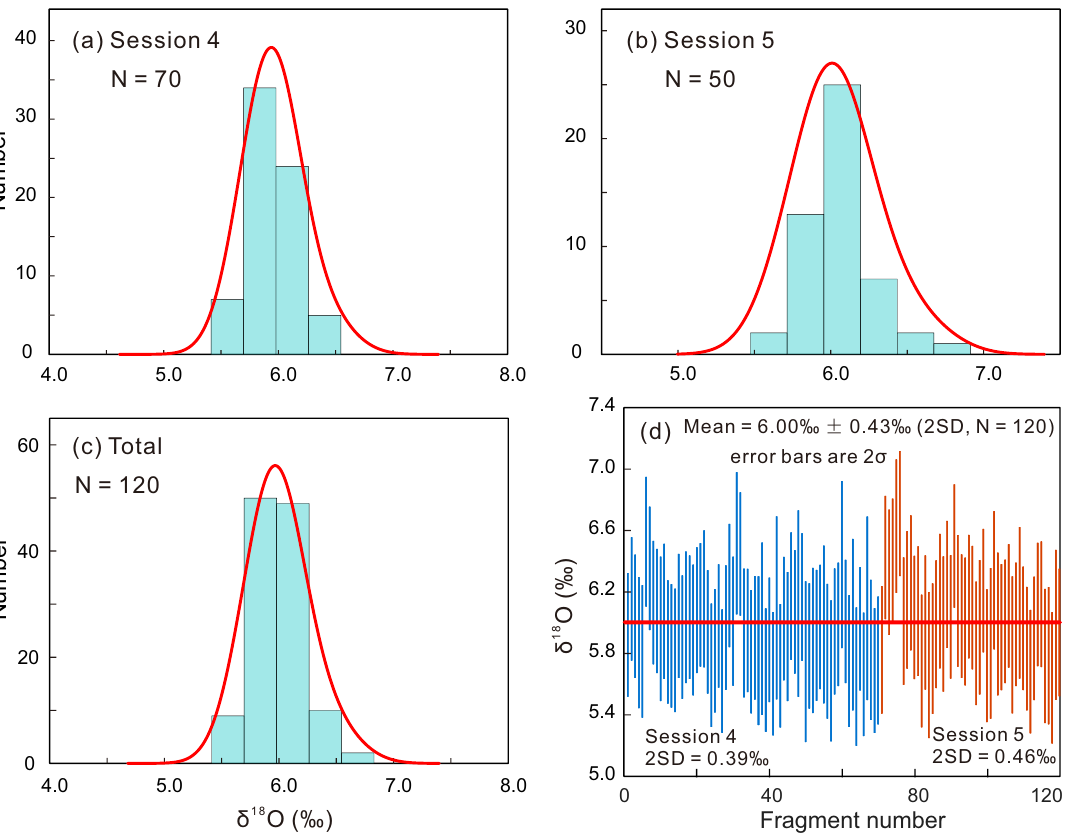
Figure 6. ( a – c ) Frequency distributions of RW-1 SIMS δ 18 O values with instrumental mass fractionation (IMF) corrected. ( d ) Reproducibility of RW-1 SIMS δ 18 O values after IMF-correction in two sessions.